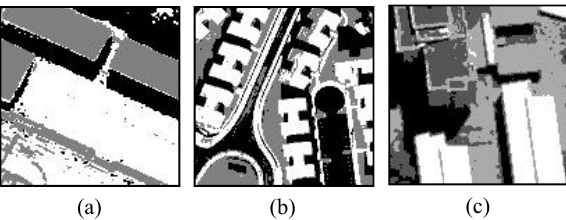
Figure 3 Segmentation results of proposed